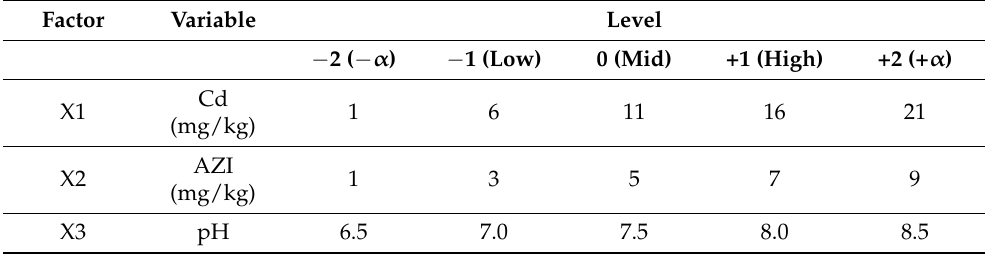
Table 2. Coded experimental range and variables for experimental